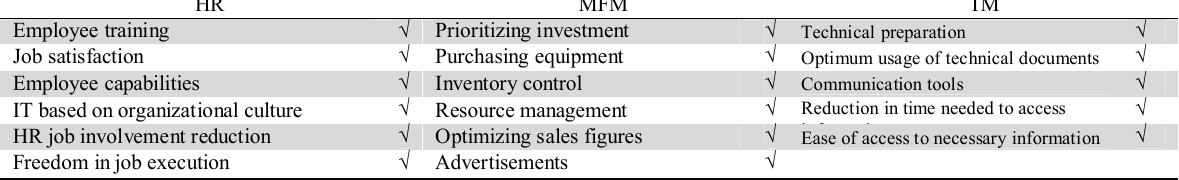
The summary of different sub-components of the survey in terms of execution strategy HR MFM TM Employee training √ Prioritizing investment